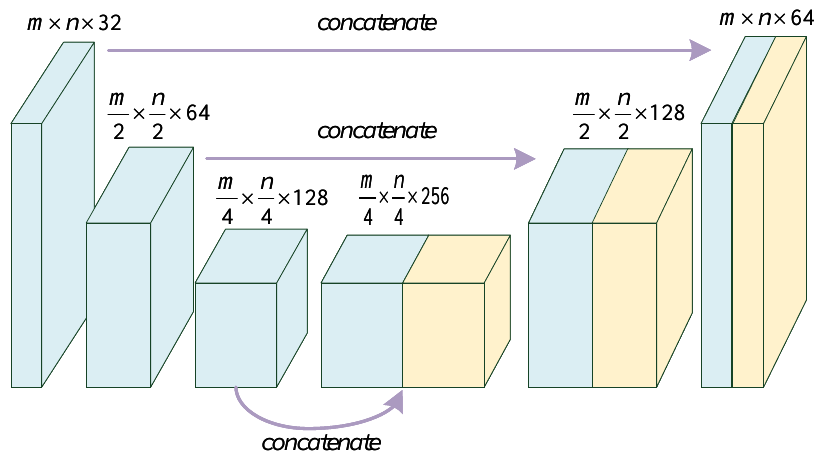
Figure 4. Depth feature extraction